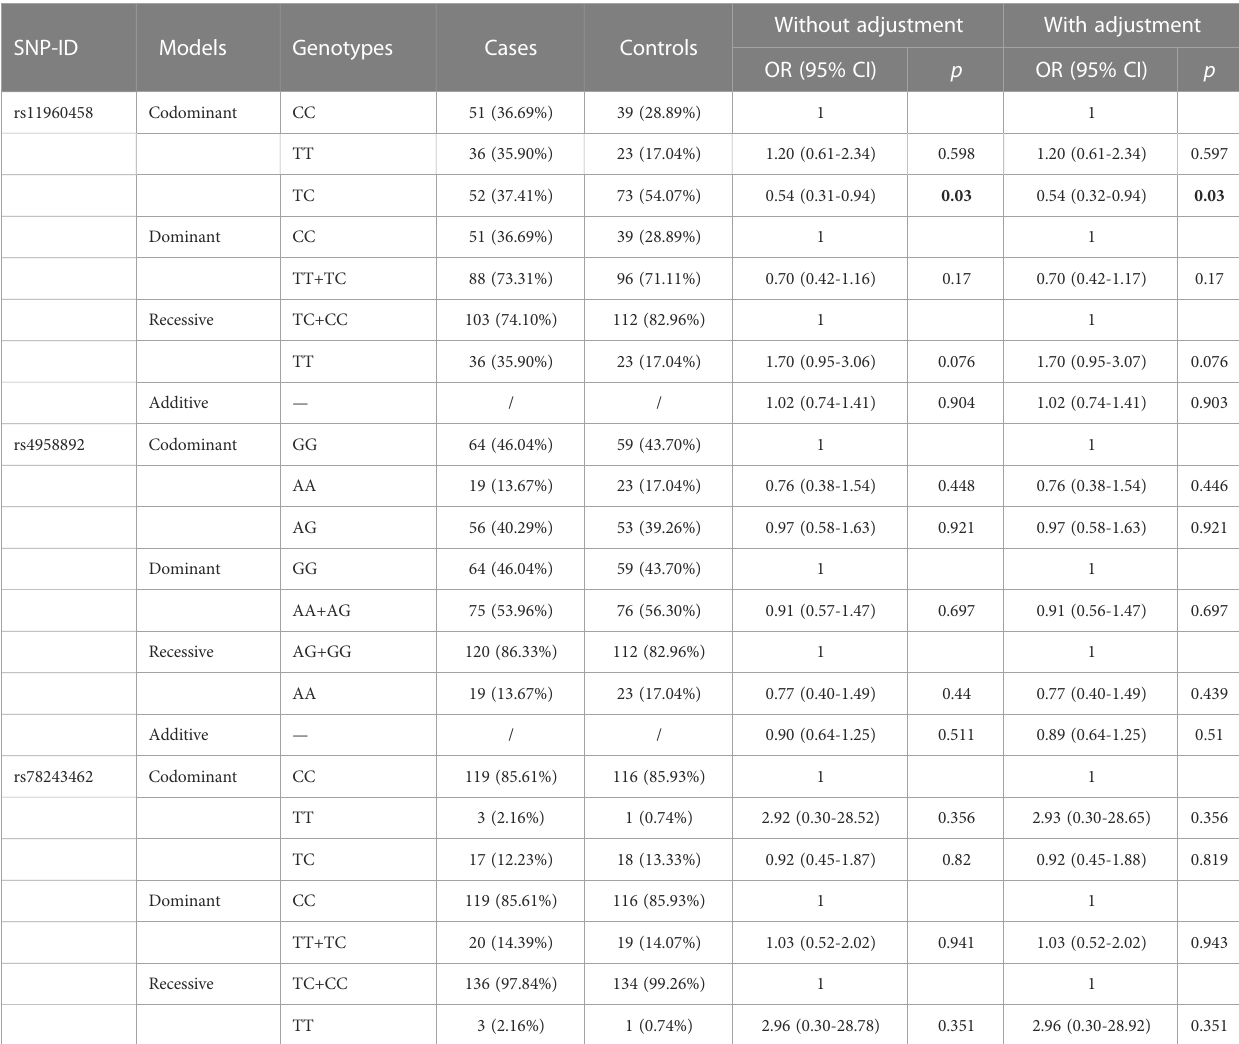
TABLE 3 Association of ANXA6 genetic variants and HNC susceptibility.